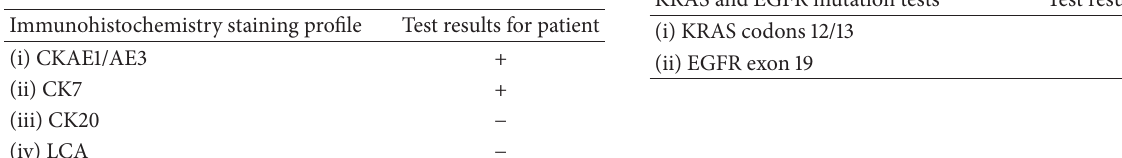
Table 1: Immunohistochemistry staining results of the Asian patient. A positive result for immunoreactivity staining indicates reactivity.